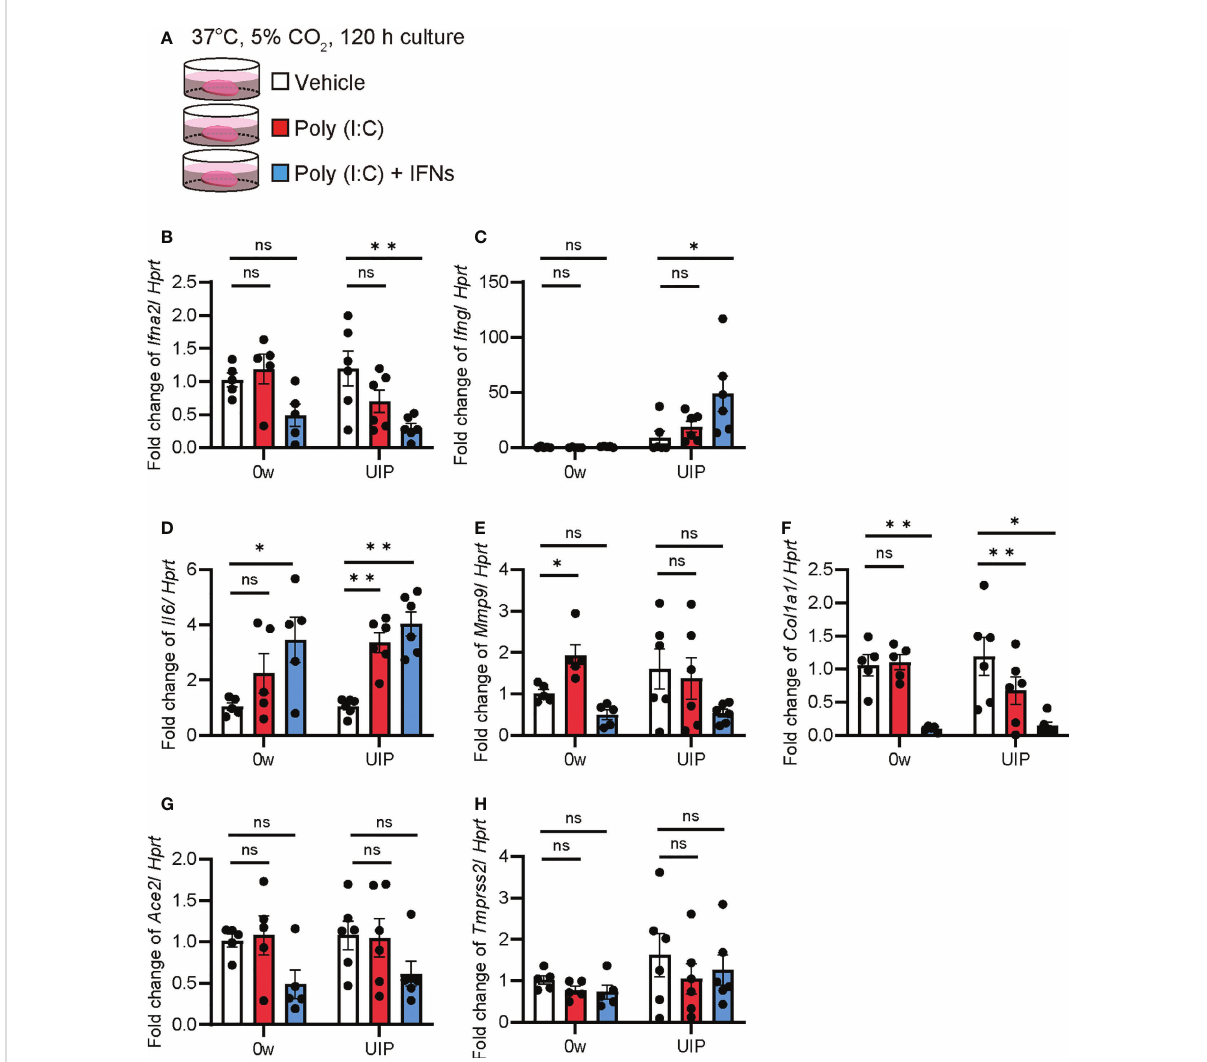
FIGURE 4 Poly(I:C) and the combination of poly(I:C) and INFs decreased Ace2 expression in ex vivo culture using PCLS qPCRs using ex vivo culture of PCLS treated with poly(I:C) and the combination of poly(I:C) and IFNs were performed. (A) Schematic diagram of the protocol using poly(I:C) and a combination of poly(I:C) and INFs in PCLS. (B – H) Fold changes in expression levels of each gene, Ifna2 (B) , Ifng (C) , Il6 (D) , Mmp9 (E) , Col1a1 (F) , Ace2 (G) , and Tmprss2 (H) at week 0 and the UIP stage. Hprt expression was used as an internal control for qPCR. Each bar represents the control (vehicle, white bar), poly(I:C) alone (red bars), poly(I:C), and the combination of poly(I:C) and IFNs (blue bars), respectively. Each mRNA was prepared from PCLS samples from each stage of the iUIP mouse model. Data are presented as mean ± SE of fi ve to six mice. Asterisks indicate * P < 0.05, ** P < 0.01, compared with week 0. “ ns ” is not statistically signi fi